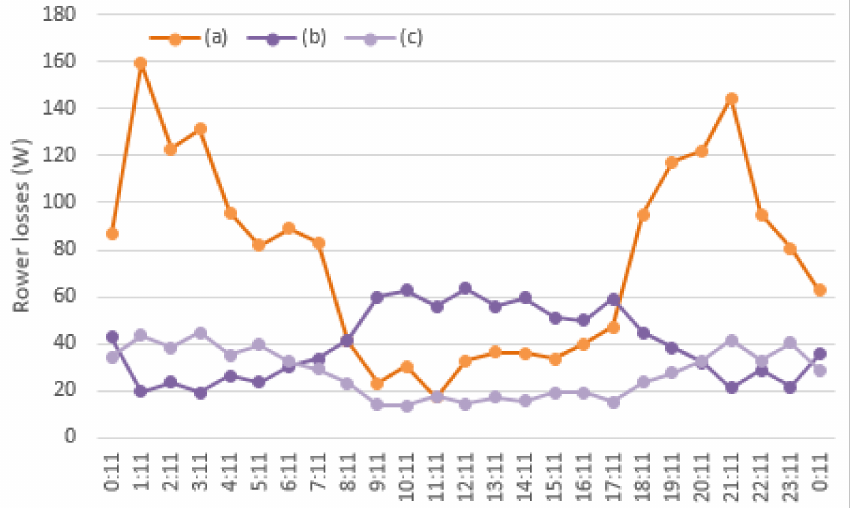
Figure 6. Transformer power losses in 24 h of a holiday due to: ( a ) active currents ( P ca ); ( b ) reactive currents with capacitors ( P (cid:48) cr ); and ( c ) reactive currents without capacitors ( P cr ). The values of the transformer power losses caused by active and reactive currents ( P ca y P (cid:48) ), represented in Figures 5 and 6, were measured by the Fluke 435 Series II analyzer cr by adjusting the resistance value to that corresponding to the short-circuit resistance of the transformer (Table 4) on the instrument’s energy loss calculator screen (Figure 1). Likewise, transformer power losses due to unbalanced and distorted currents were significantly lower than those caused by reactive currents (Figures 7 and